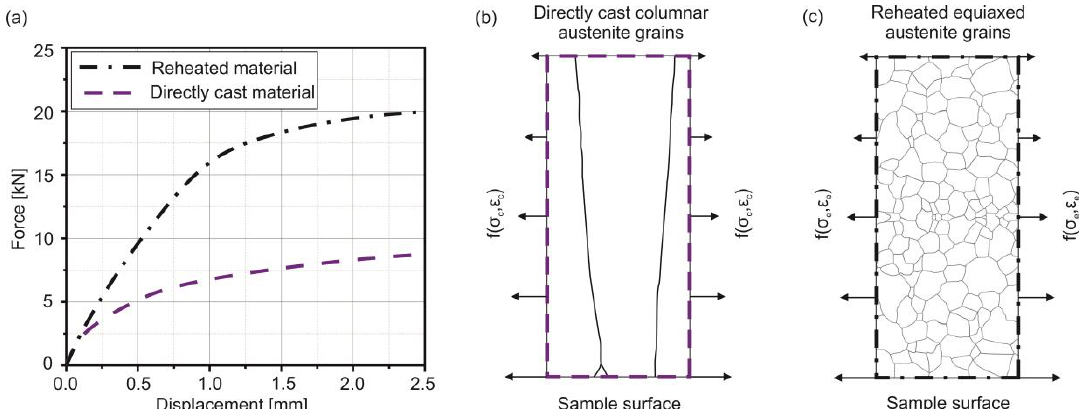
Figure 4. ( a ) Mechanical response of samples from low-carbon steel directly-cast and reheated, ( b ) Schematic view of a directly-cast coarse columnar austenite grain structure [ 21 ], ( c ) Schematic illustration of austenitic microstructure of a reheated sample [ 22 ].